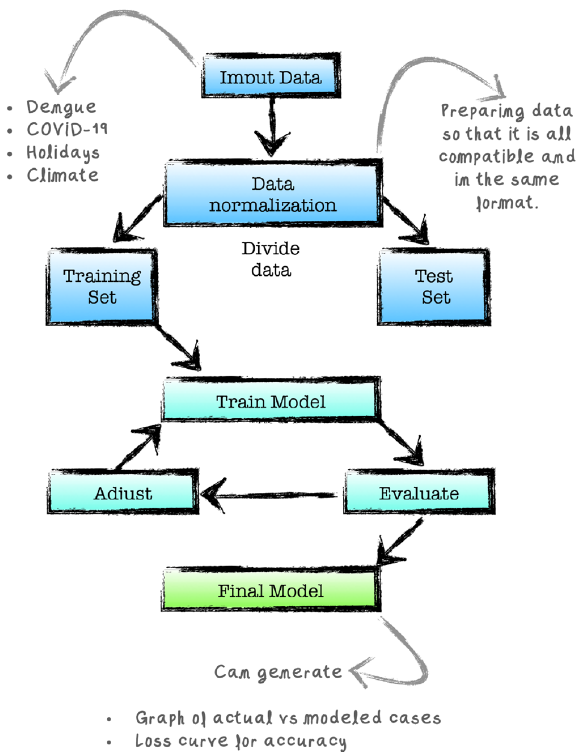
Figure 7. The workflow diagram of our correlation model.